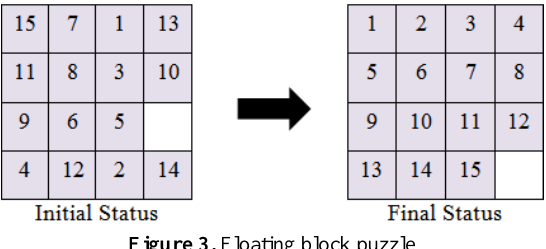
Figure 3. Floating block